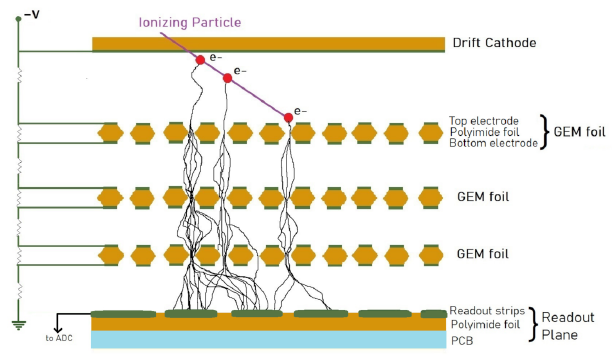
Figure 1. A diagram of a particle detector based on GEM